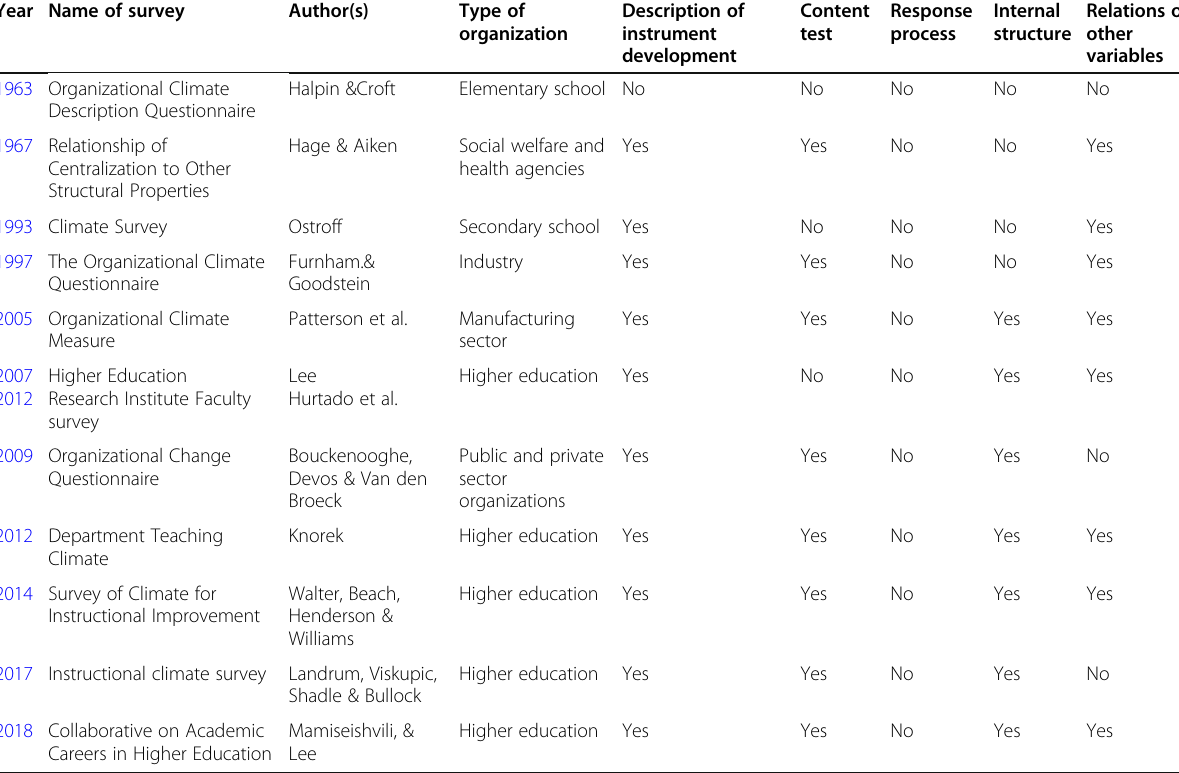
Table 1 List of surveys measuring climate within an